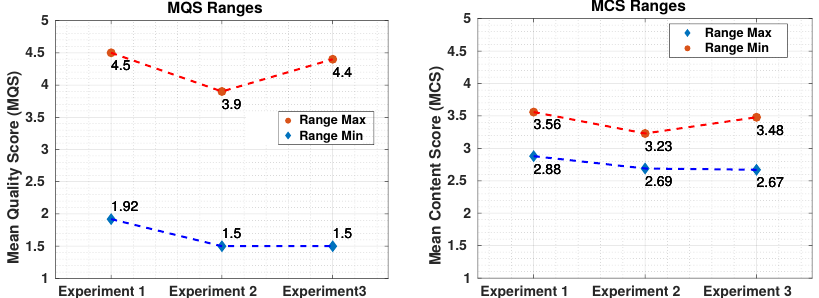
Figure 14. Ranges of quality and content scores in Experiments 1, 2 and